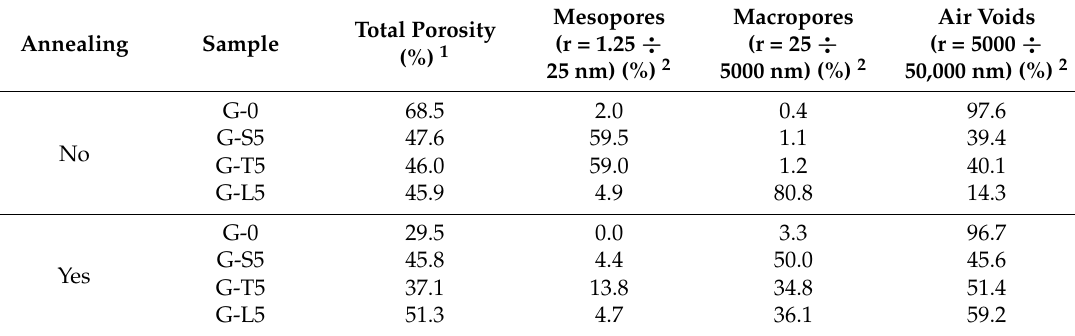
Table 5. Results of MIP analyses on geopolymers containing biomass, in terms of total porosity and pore size distribution.